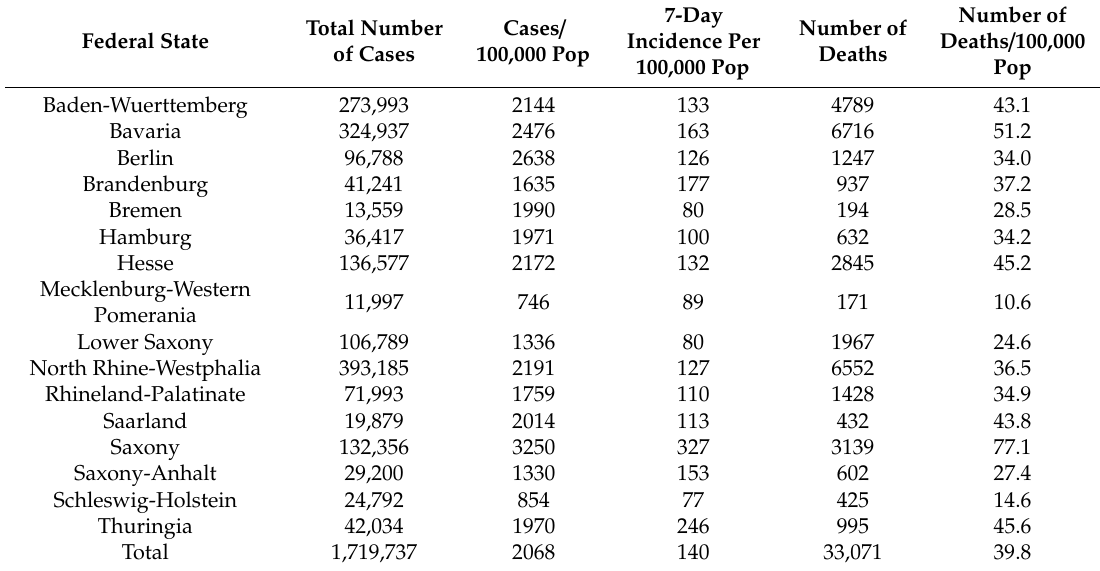
Table 1. Cases and deaths for each federal state (RKI, Germany 31 December